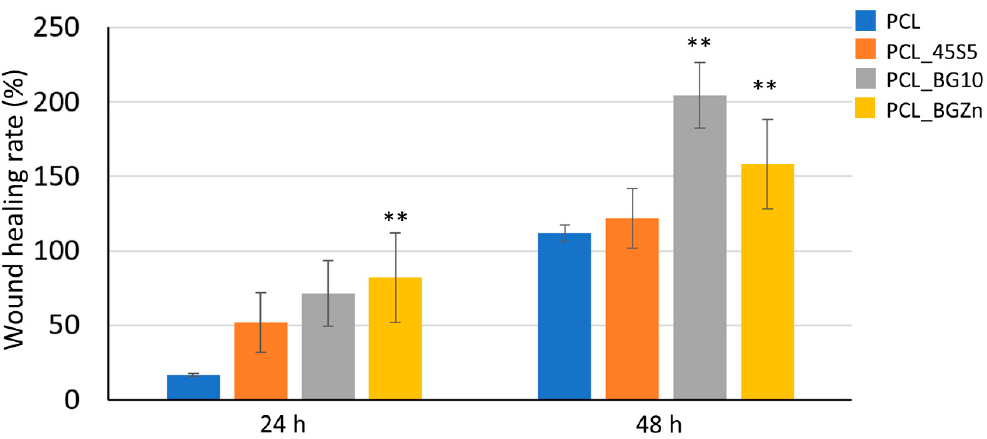
Figure 9. Wound-healing rate % (measured as cell migration rate %) 24 h and 48 h after the introduction of the “scratch” in confluent monolayers of NIH 3T3 cells in contact with eluates of PCL, PCL_45S5, PCL_BG10, and PCL_BGZn composite electrospun mats. ** p < 0.05.